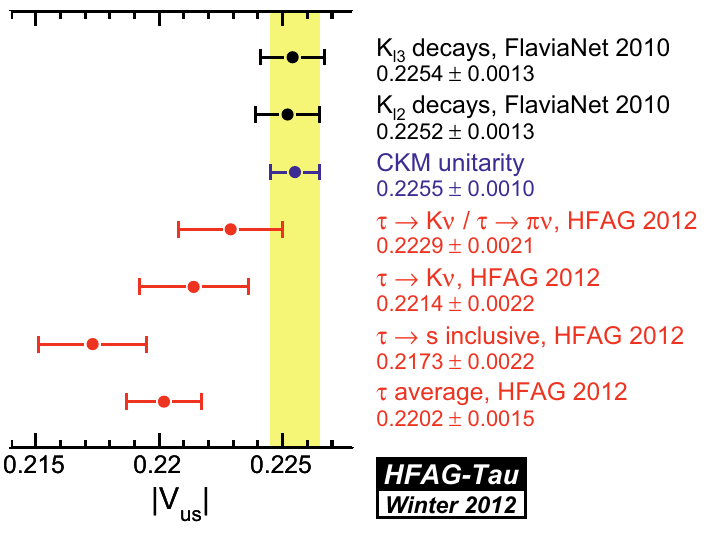
Figure 3. An update of | V us | from the HFAG 2012 report[1] for the hadronic τ decays. The HFAG values of | V us | are extracted using the average branching fractions from HFAG. The three upper values are from K l 3 decays [49], K l 2 decays [49] and the unitarity constraint